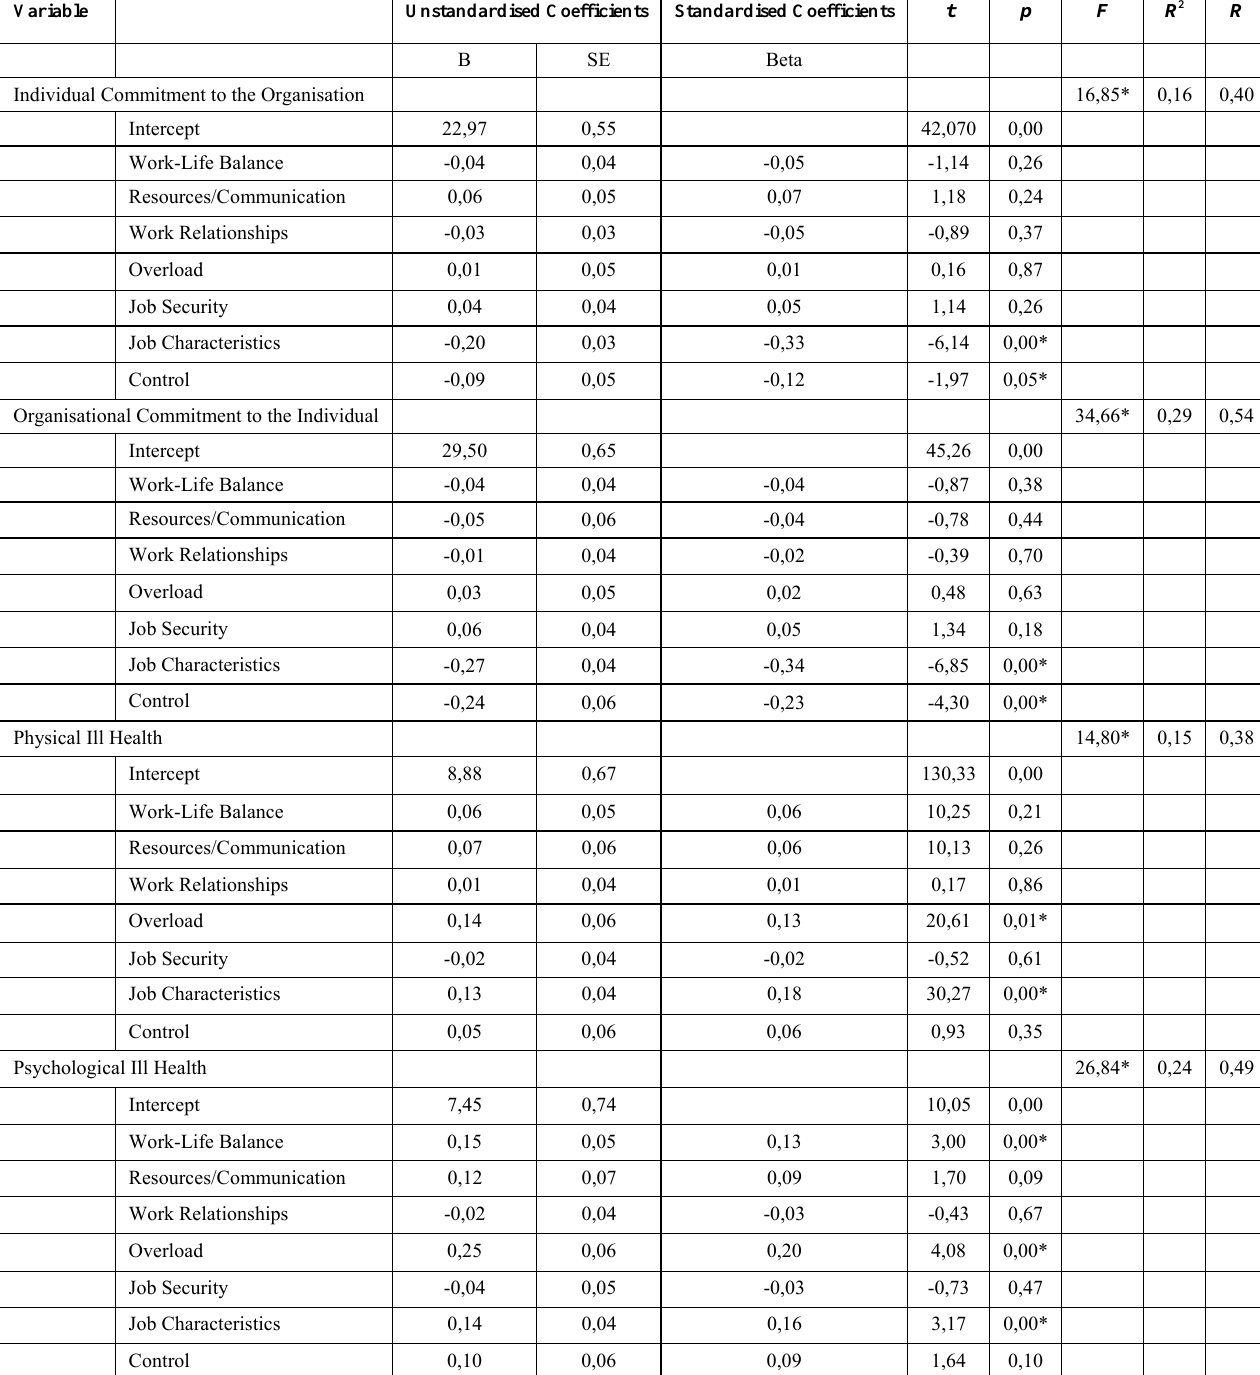
Table 4: Standard multiple regression analyses